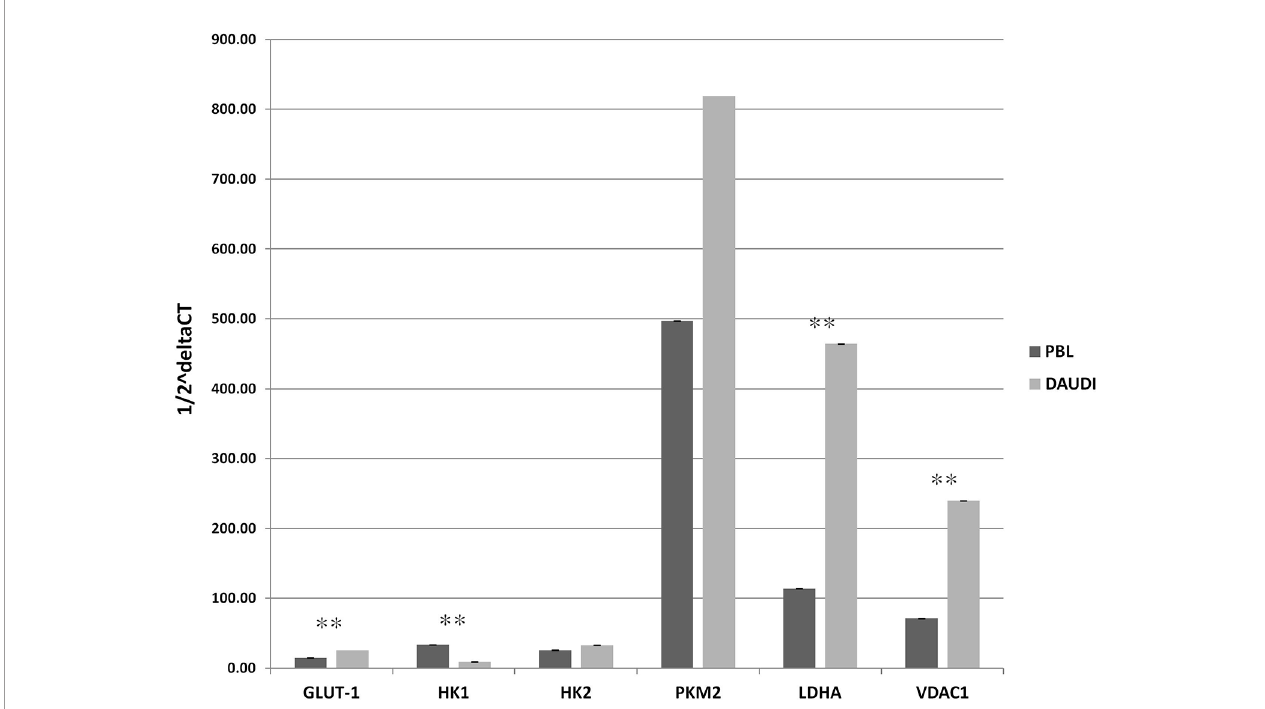
FIGURE 3 | Gene expression of glucose metabolism genes in DAUDI cells vs . PBL. The gene expression of selected targets involved in glucose metabolism was evaluated by RT-qPCR in both DAUDI cells and PBL. Beta-actin was used as reference gene. Values represent the relative amount of each transcript in the two cell types. Values are means and SEM of four independent experiments (Mann-Whitney U-test, **two-tailed p-values ≤